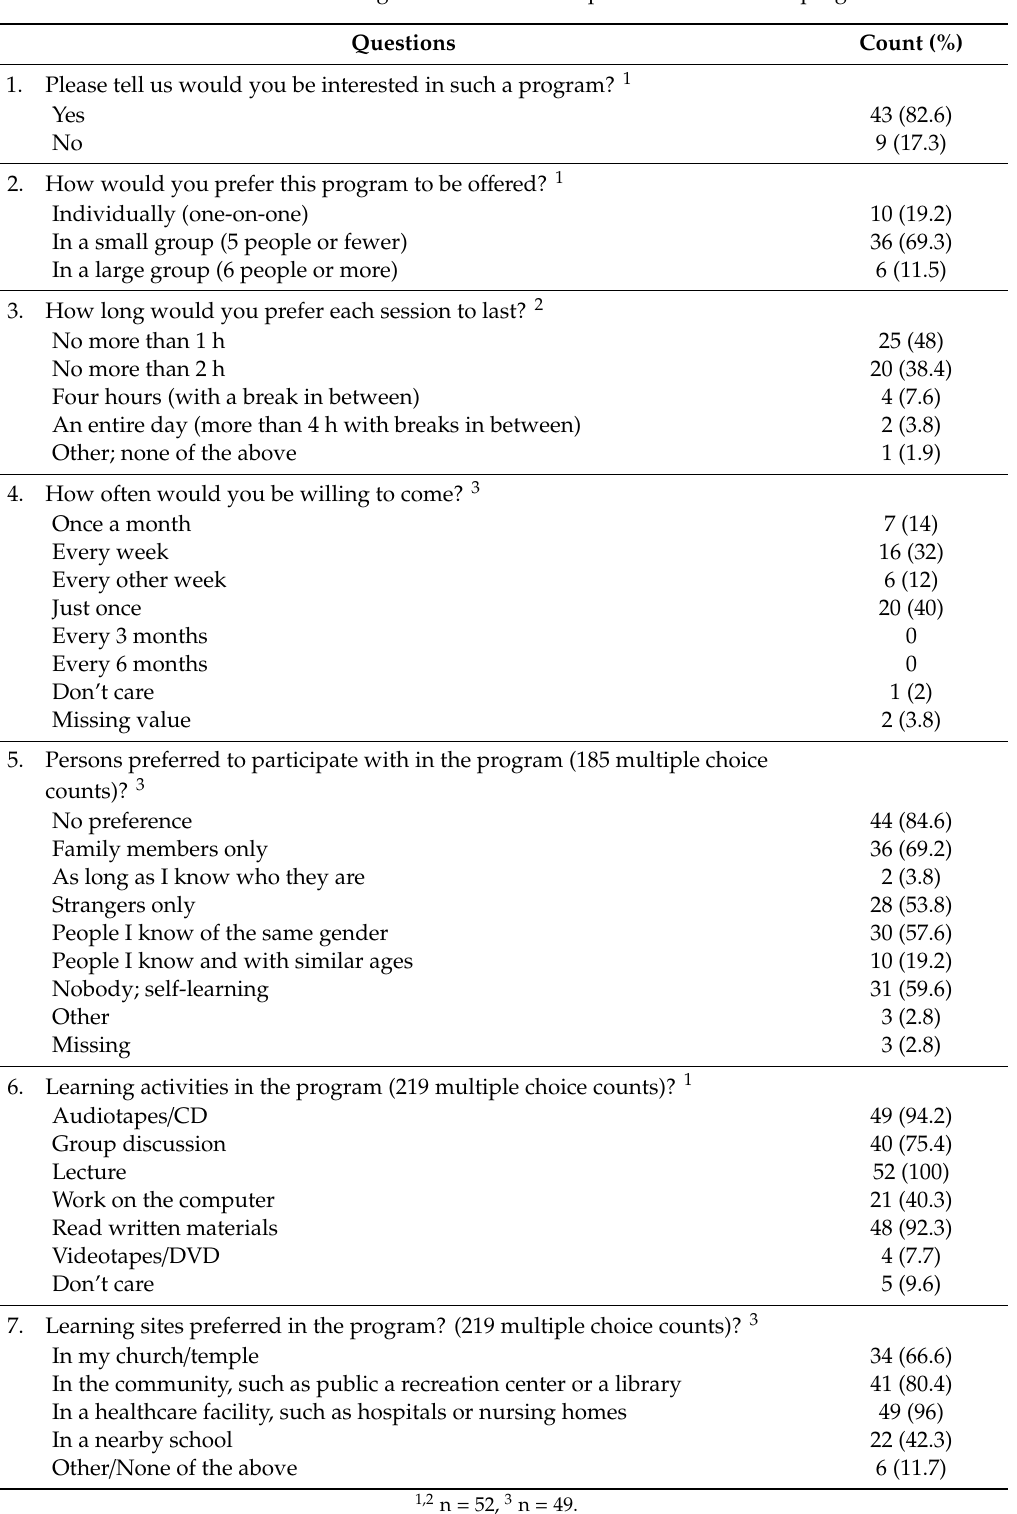
Table 5. Intervention strategies older Taiwanese preferred in the ACP